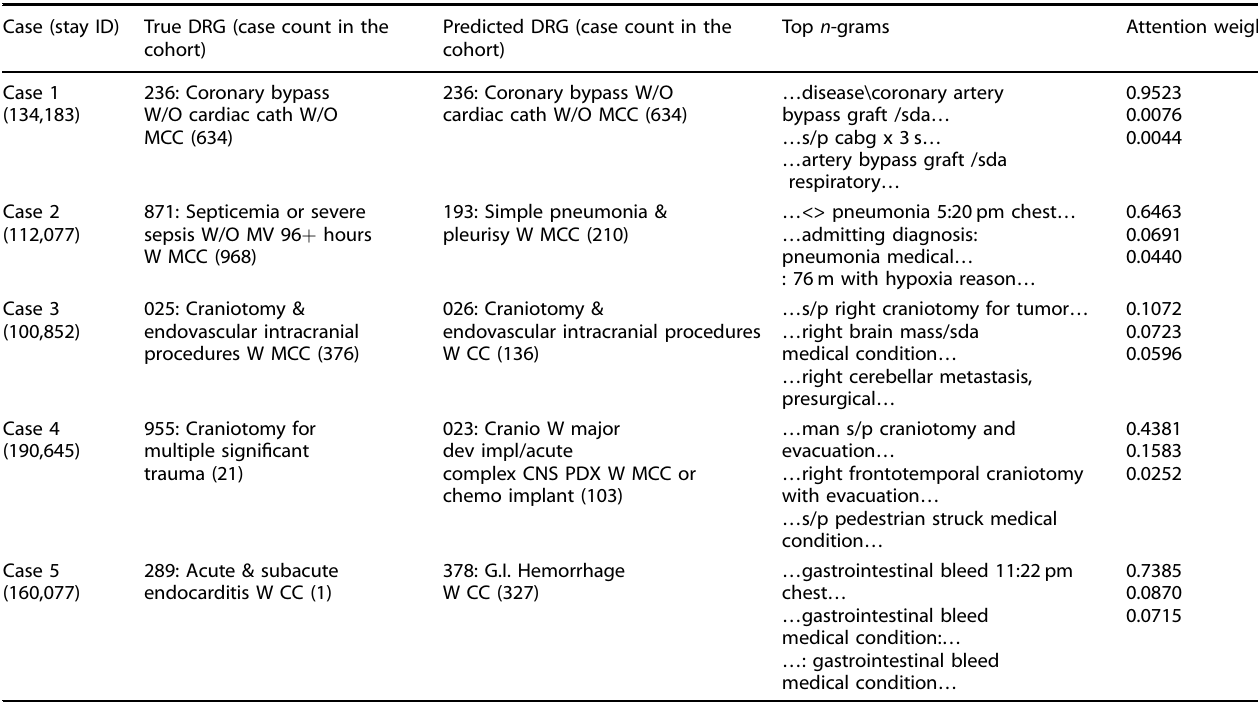
Table 3. Case analyses on DRG